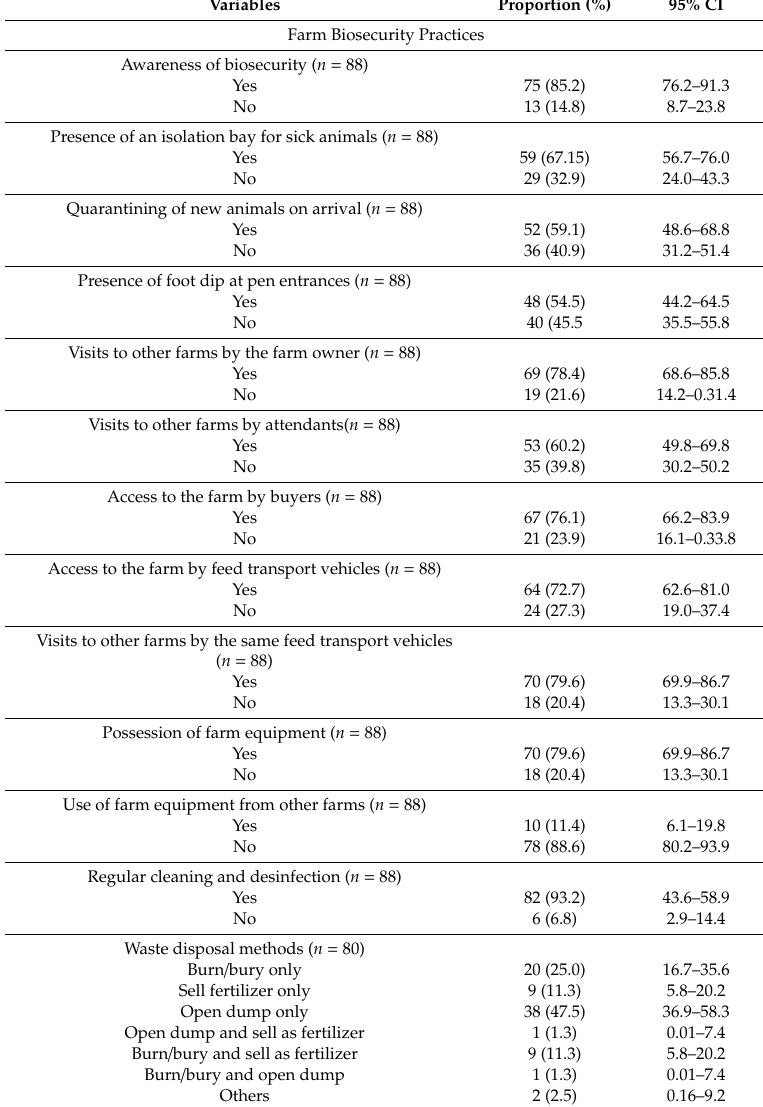
Table 3. Farm biosecurity on the studied pig farms in Ogun State,